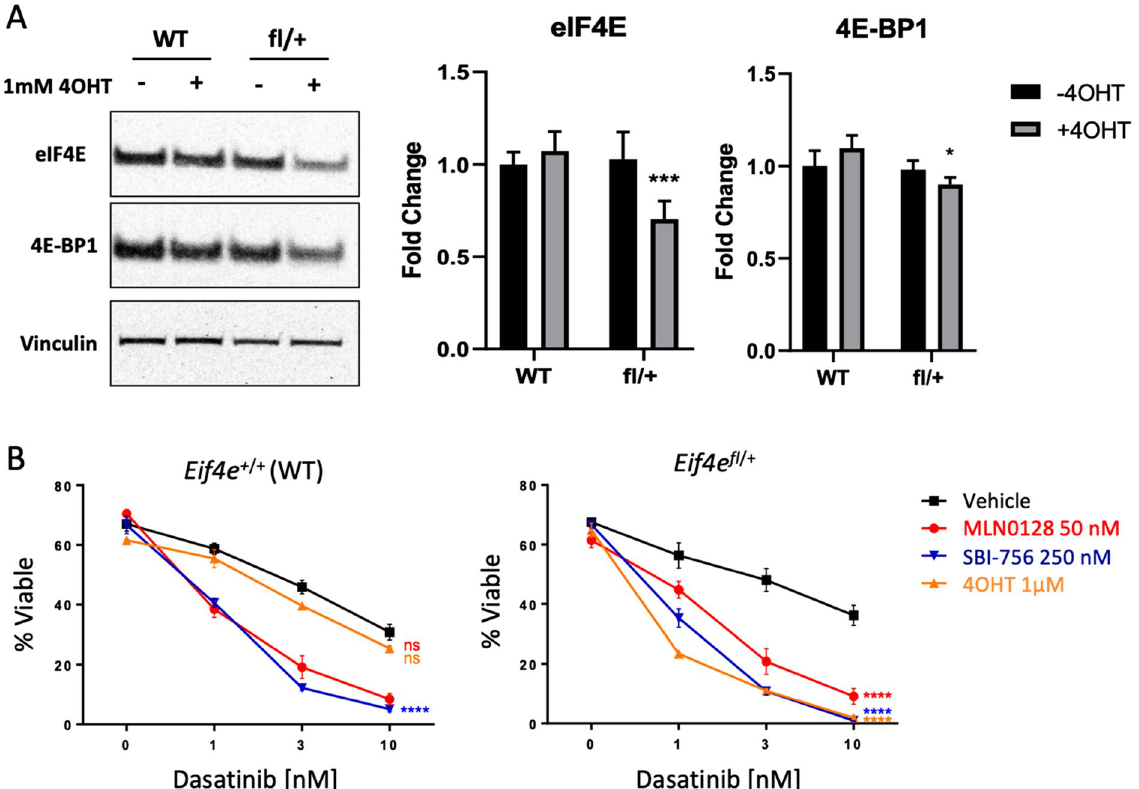
Figure 2. Reduced Eif4e gene dosage sensitizes BCR-ABL-dependent cells to dasatinib. ( A ) eIF4E expression was assessed by Western blot in pools of p190 cells from Rosa26-CreER mice with WT (+/+) or heterozygous floxed (fl/+) Eif4e . Cells were treated without or with 4OHT for 72 h prior to lysis. Graph on the right shows relative expression of eIF4E and 4E-BP1 over several independent p190 pools (n = 6–9). Fold change calculated using total Erk or vinculin as loading control. Data are expressed as mean ± S.E.M. Significance was calculated using paired t-test (* p < 0.05; *** p < 0.001, n = 6–9) ( B ) Viability assay of p190 cells treated as indicated for 48